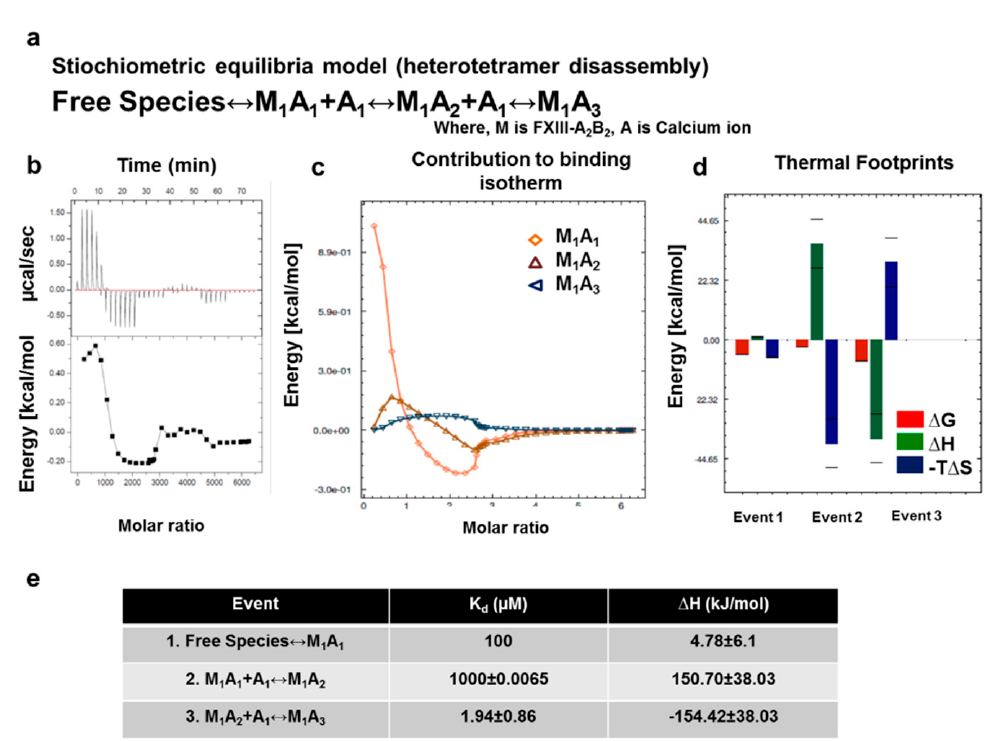
Figure 7. In-solution dissociation of FXIII complex in the presence of thrombin and calcium studied by ITC. ( a ) is the equation depicting the stoichiometric binding equilibrium model followed for the analysis of data derived from ITC (model was generated in A ffi nimeter using model builder approach). ( b ) represents the titration of 1.25 mM FXIII-A 2 B 2 , with 25 mM CaCl 2 . Upper image of this panel is the ORIGIN raw data depicting the heat change upon each injection and the lower image in this panel is the normalized data, with integrated heat change plotted against the concentration ratio of CaCl 2 vs. FXIII. A solid black line represents the corresponding fit obtained in Origin software using one-set of binding mode. (blank controls not shown) ( c , d ) are based on A ffi nimeter analyses depicting the contribution of individual reactants of equation ( a ) towards the isotherm. The heat signatures depicting the free energy changes, changes in enthalpy, and entropy in the two events explained in Figure 6a, respectively. ( e ) is a table explaining the three thermodynamic events, and their corresponding dissociation constants (K d ) and changes in enthalpy ( ∆